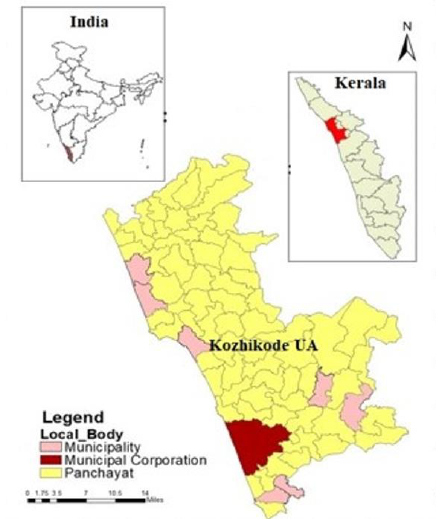
Figure 1 : Location map of the study area